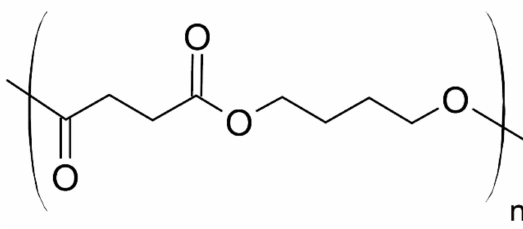
Figure 2. Poly(butylene-succinate).